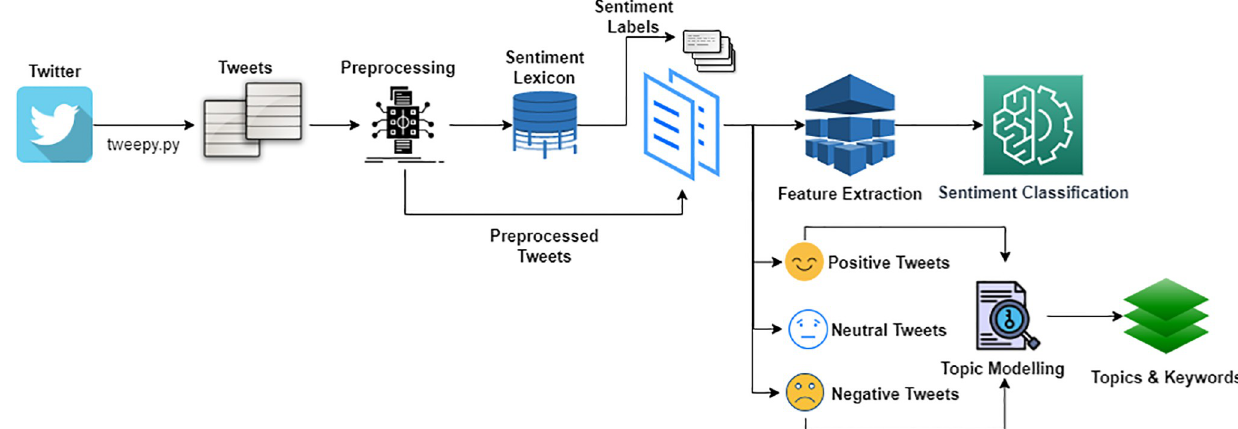
Fig 1. General framework of the proposed sentiment classification process.